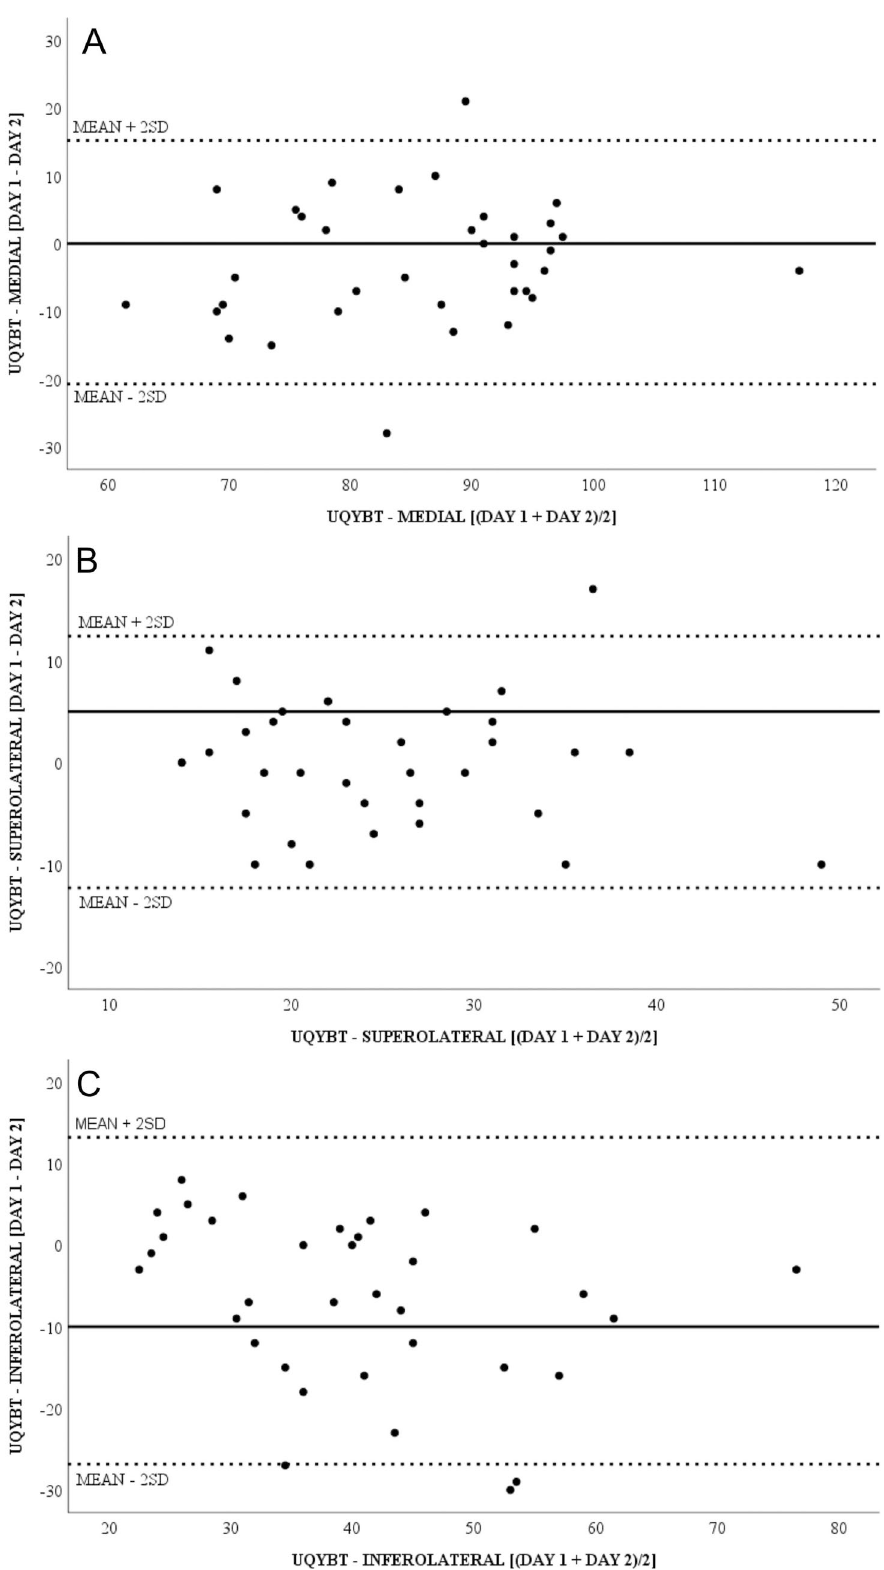
Figure 3 - Bland-Altman Plot for the three directions of the Upper Quarter Y Balance Test in the left upper limb: A) medial; B) superolateral; C) infer- olateral. The straight line represents bias and dotted lines 95% limits of